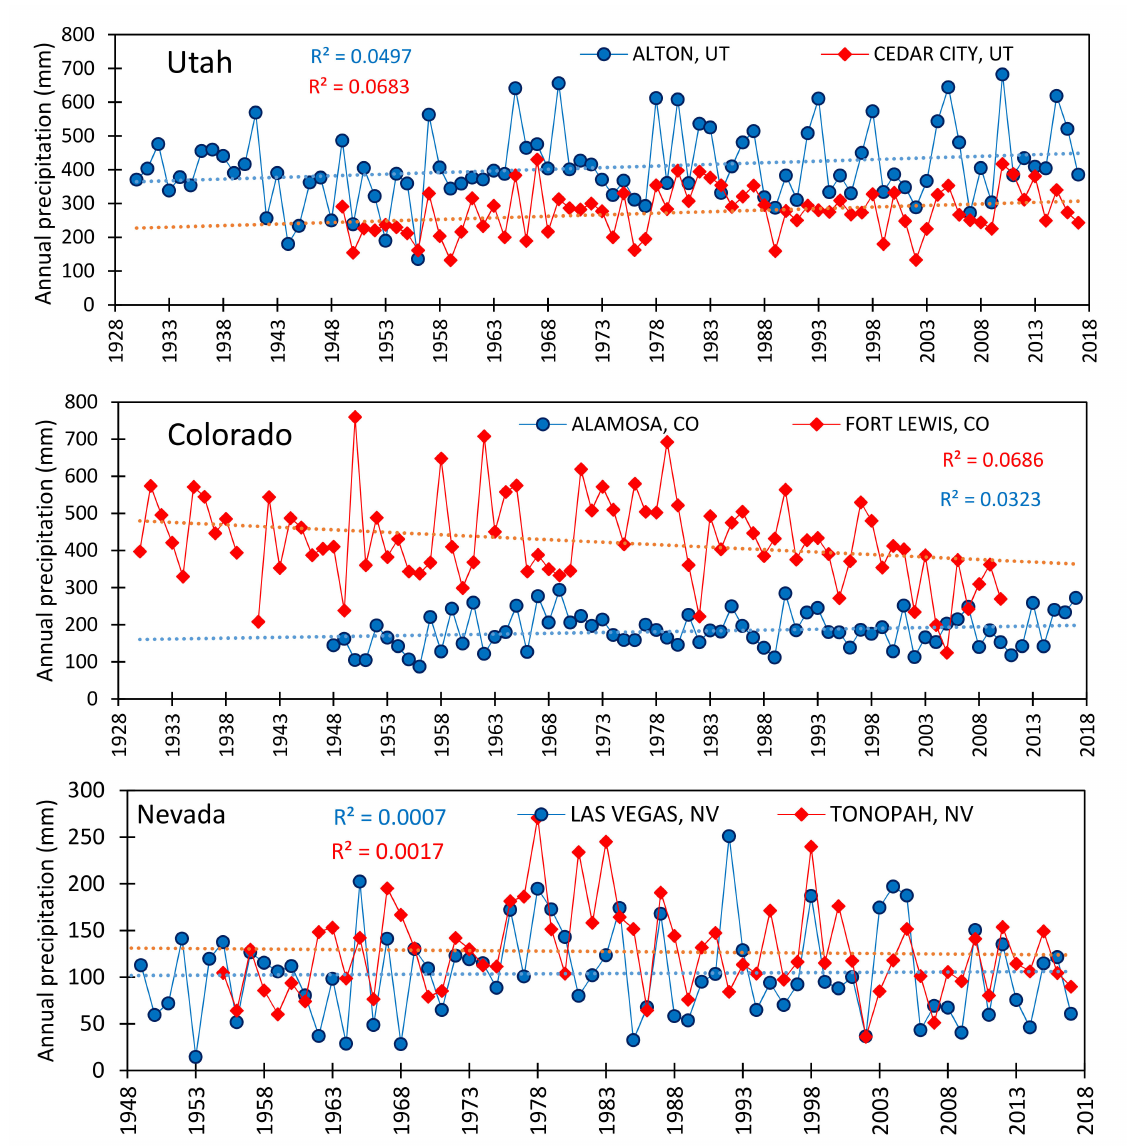
Figure 2. Temporal trend in annual precipitation in the states of Texas, New Mexico, Colorado, Arizona, Utah, Nevada, and